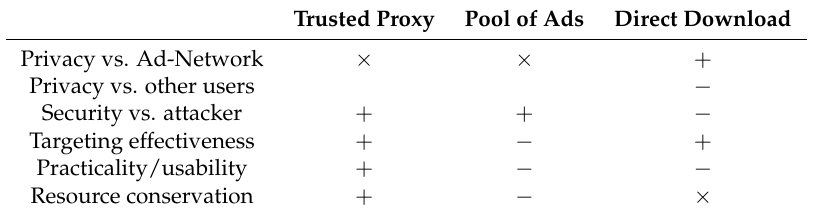
Table 1. Assessment of categories of ad-delivery systems (good: “ + ”; adequate: “ × ”; poor: “ − ”). Trusted